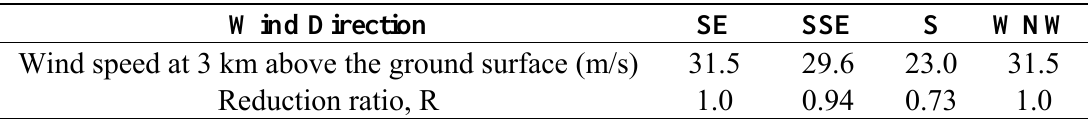
Table 3. The reduction ratio, R, of the upper-air wind speed at the inflow boundary for the RIAM-COMPACT ® CFD